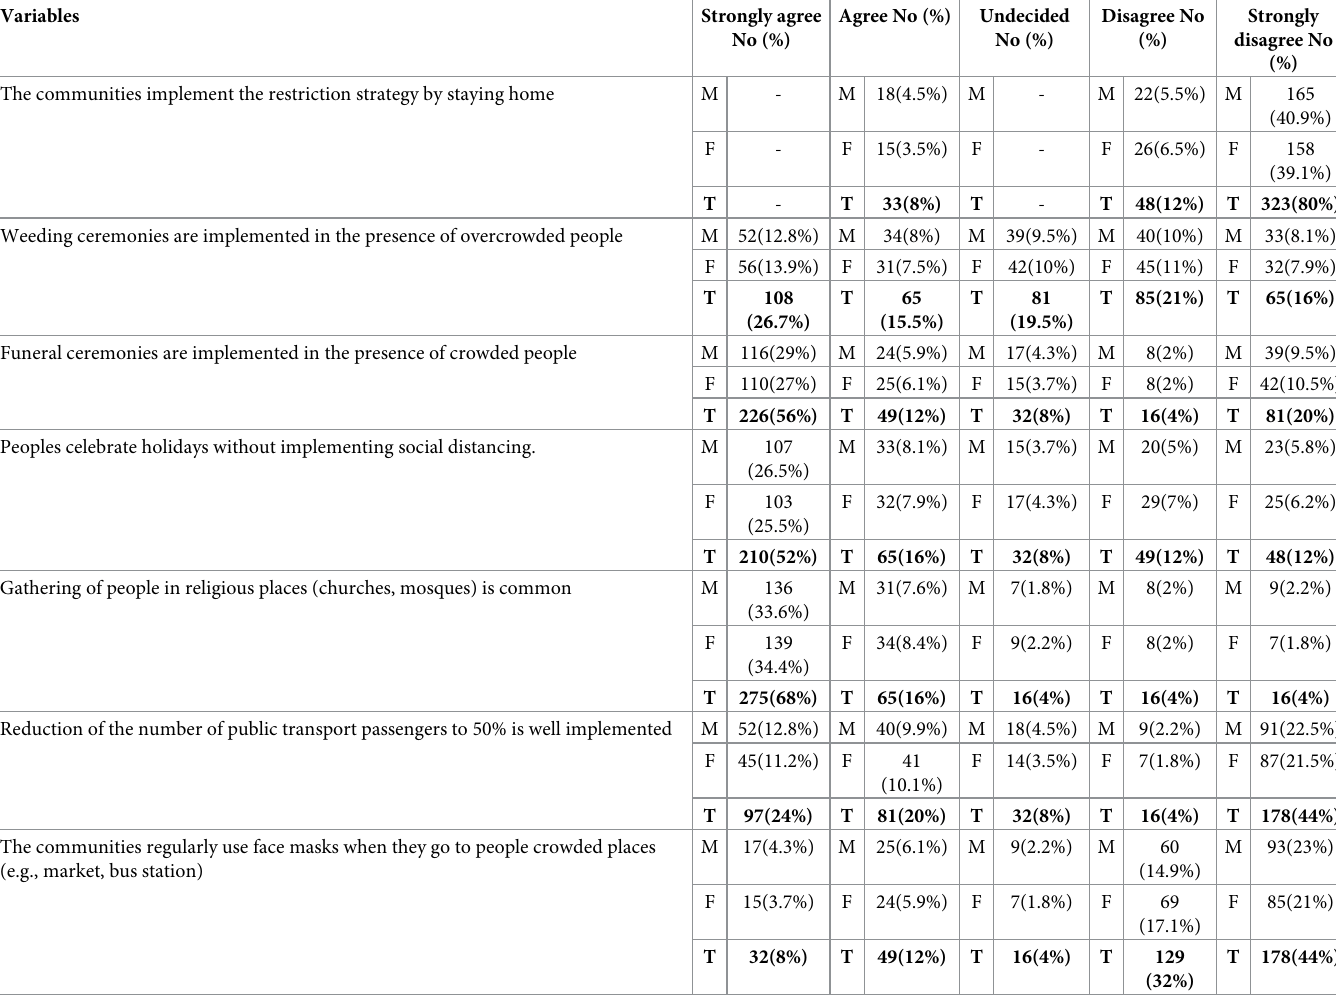
Table 8. Community’s practices to implement government restriction strategies to prevent COVID-19 (n = 404).